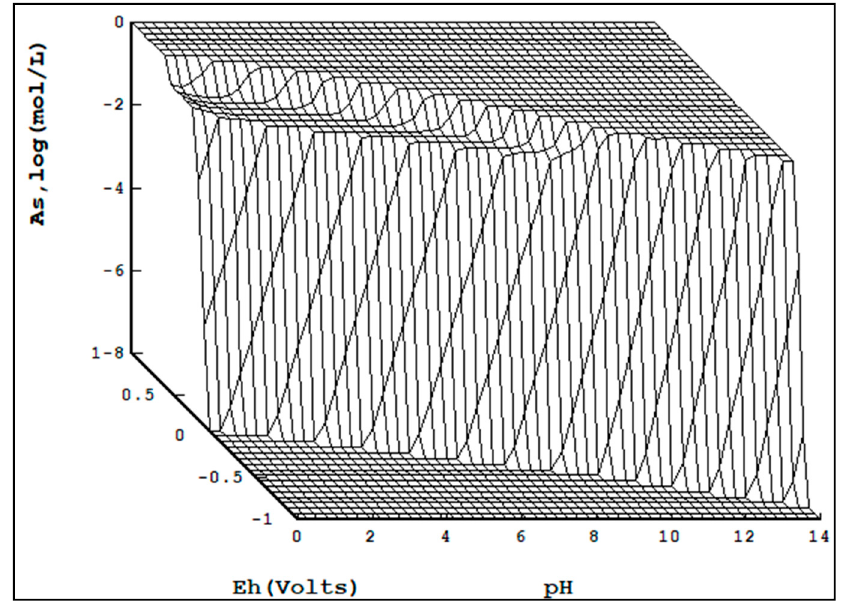
Figure 5. 3D As Pourbaix diagram.